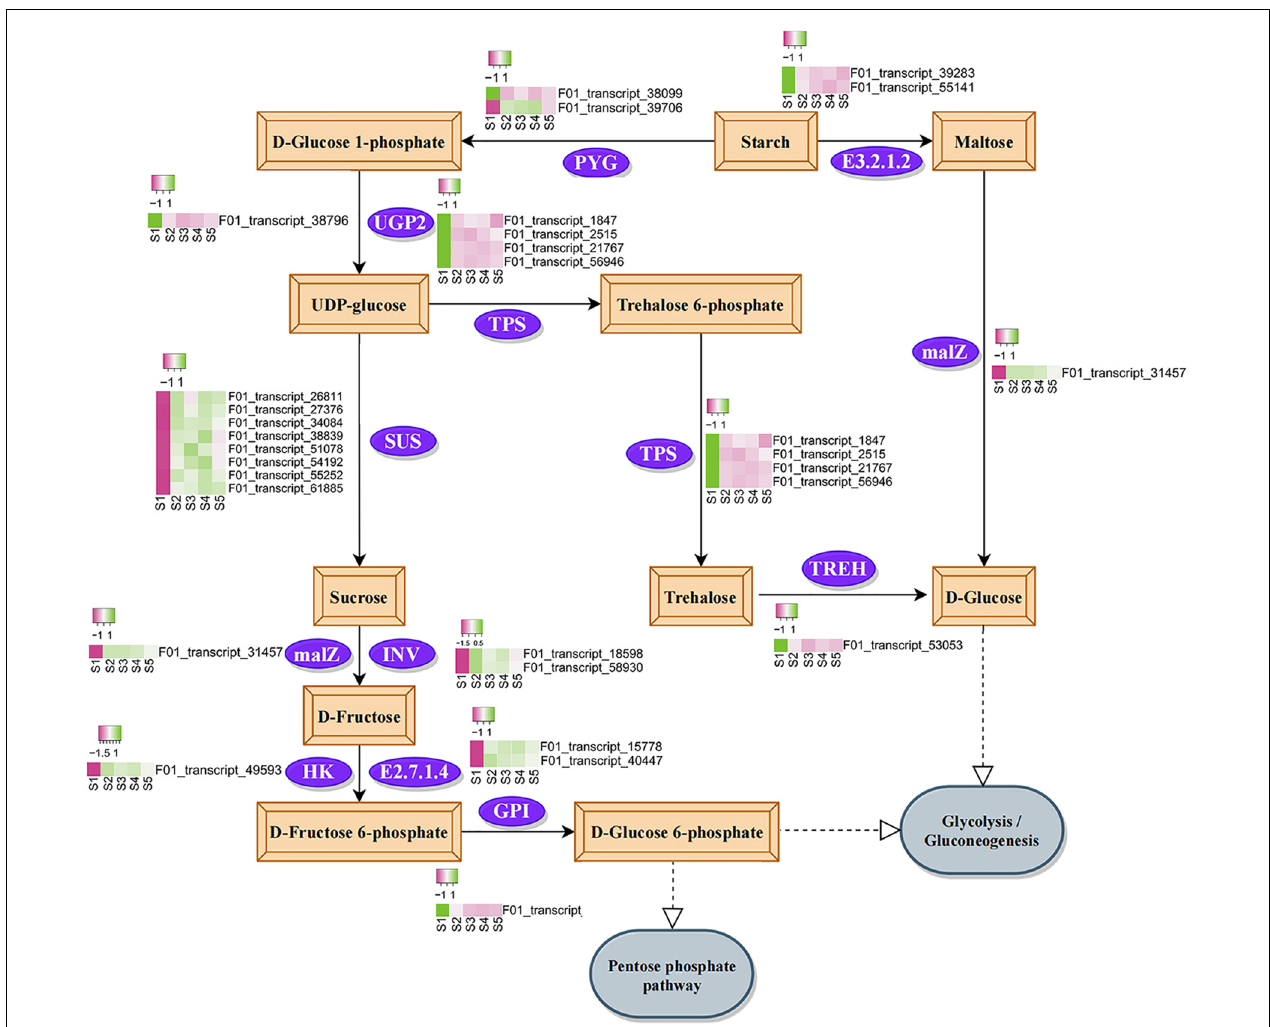
FIGURE 7 | Annotated diagram of differential expression of Kyoto Encyclopedia of genes and genomes sucrose and starch metabolic pathways. The purple box indicates low gene expression, and the green box indicates high gene expression. The meaning of the label is to process the value of each row separately to make it conform to the standard normal distribution. PYG , glycogen phosphorylase; UGP2 , UTP-glucose-1-phosphate uridylyltransferase; SUS , sucrose synthase; malZ , alpha-glucosidase; INV , beta-fructofuranosidase; HK , hexokinase; E2.7.1.4 , fructokinase; GPI , glucose-6-phosphate isomerase; TPS , trehalose 6-phosphate synthase/phosphatase; TREH , alpha, alpha-trehalase; E3.2.1.2 ,